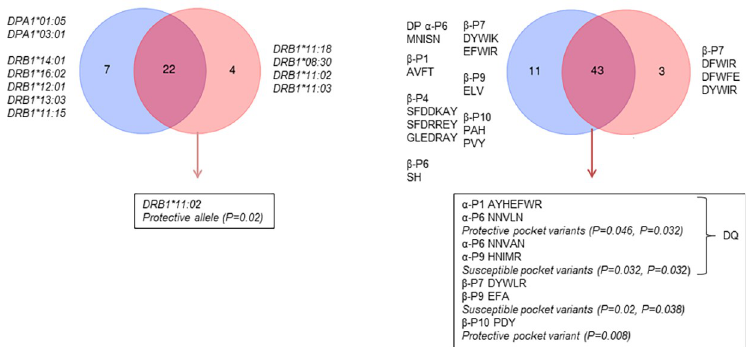
Fig 3. The distribution of alleles and pocket variants in WNND (blue) and WNF (light red). Next to each group are listed the alleles that were unique for the group. In the boxes below, the alleles/pocket variants that were associated positively or negatively with neuroinvasion are shown.